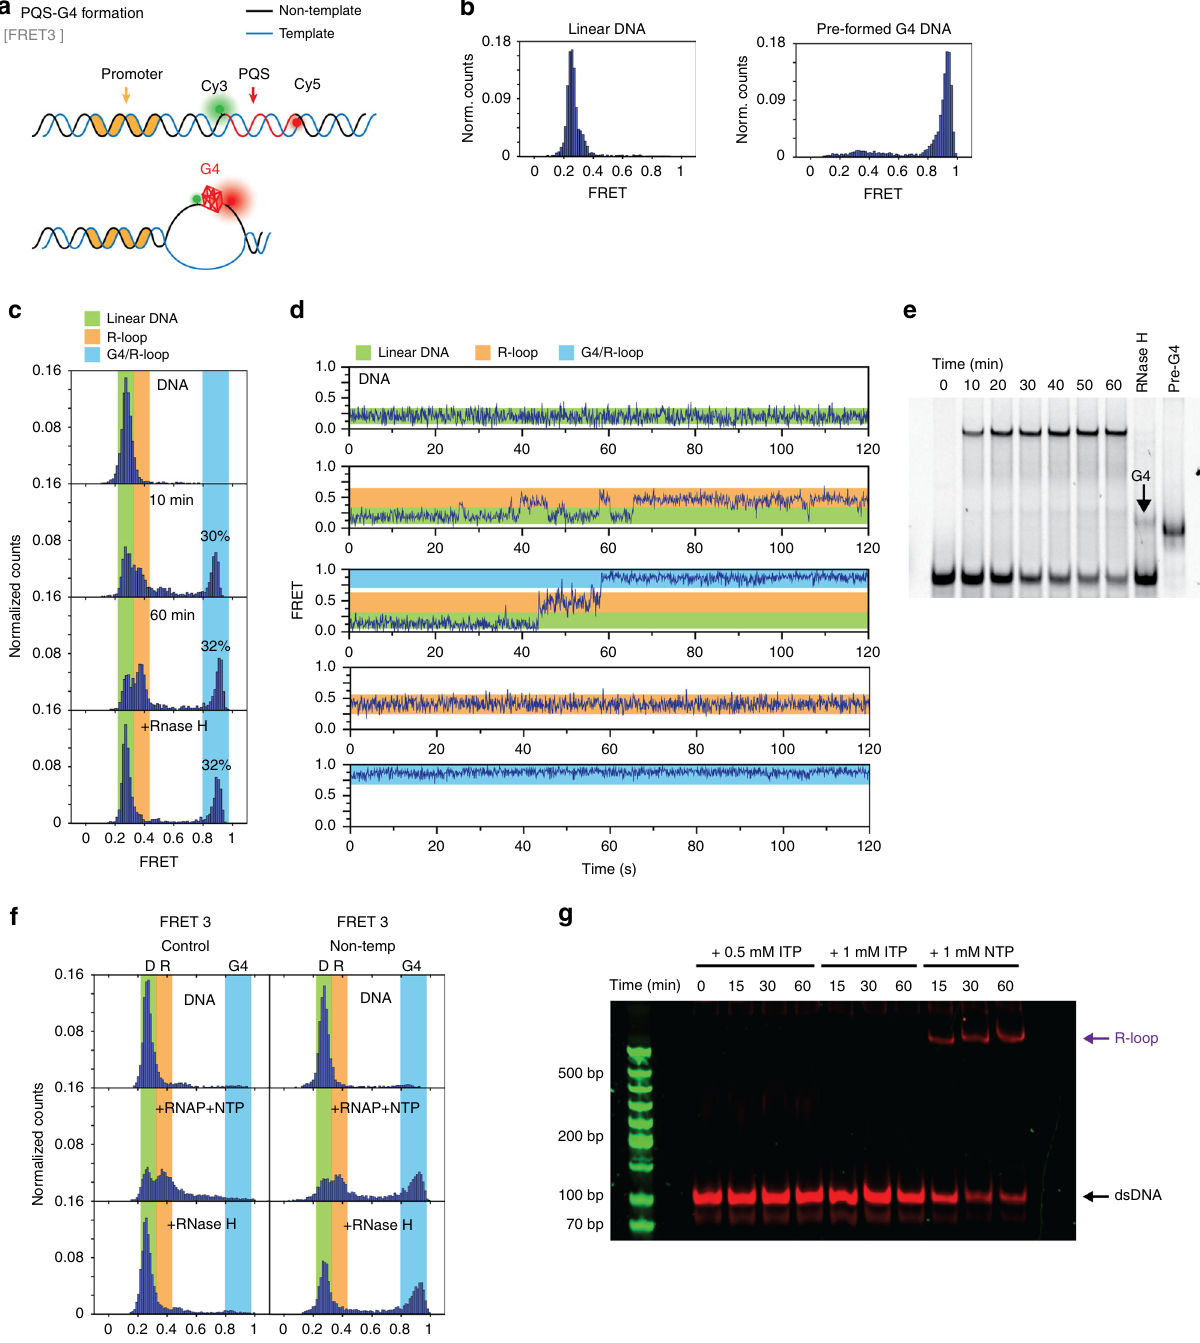
Fig. 7 G4 forming during transcription is detected by single-molecule FRET. a Scheme shows how FRET3 construct can probe the formation of G4. b The FRET histogram shows that both linear dsDNA and pre-formed G4 DNA have one sharp peak at 0.25 and 0.9, respectively. c FRET peak (0.25) transits to higher FRET population, 0.4 and 0.9 during transcription, indicating the formation of R-loop and G4/R-loop. d Trace examples of FRET3 shows three distinguishable FRET states. The transition occurs between 0.25 and 0.4, indicating the conversion of linear DNA to R-loop state. Transition from 0.4 to 0.9 indicates the formation of G4 structure requires R-loop forming fi rst. e Similar to c , the G4 formation during transcription can be visualized through removal of hybrid DNA:RNA by RNase H treatment. Here, a 10% PAGE KCl gel (100 mM) is used to distinguish G4 DNA from linear DNA. The image is a representative gel from n = 2 independent experiments and taken under Cy5 emission. Source data of full scan image and molecular marker is stained separately and provided as Source Data fi le. f FRET3 control and non-template test shows the 0.4 is R-loop state and 0.9 is G4 structure. There are only two peaks in control, indicating no G4 structure. The 0.4 peak is R-loop, demonstrated by RNase H digestion. D is linear DNA; R is R-loop; G4 is G4/R-loop. g ITP substitution prohibits R-loop formation and causes disappearance of R-loop bands. The image is a representative gel from n = 2 independent experiments. Source data of full scan image is stained separately and provides as Source Data fi